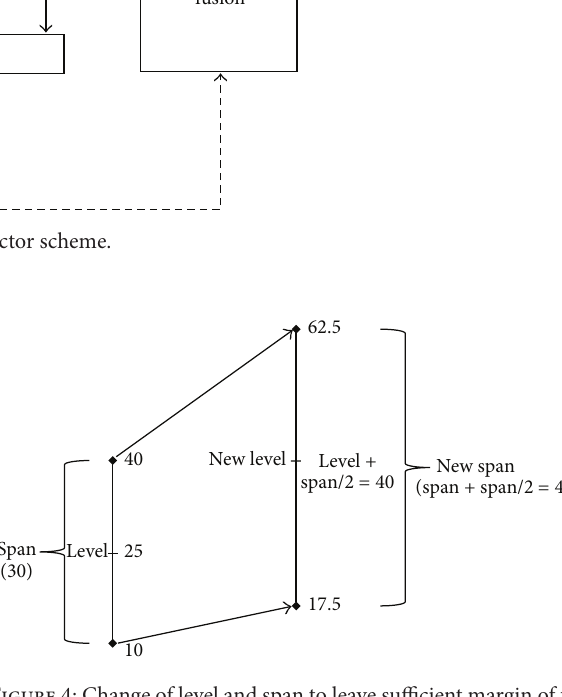
Figure 4: Change of level and span to leave sufficient margin of fire